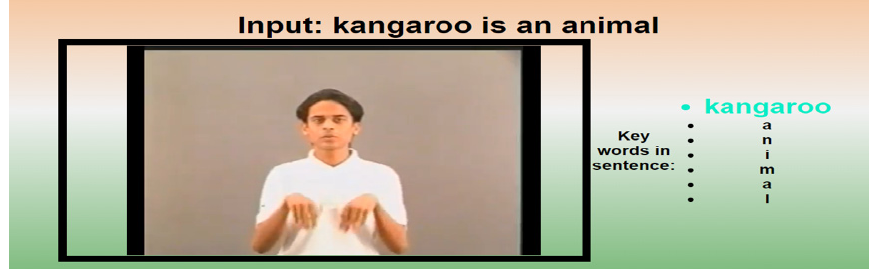
Figure 13. Case 5. Available video for